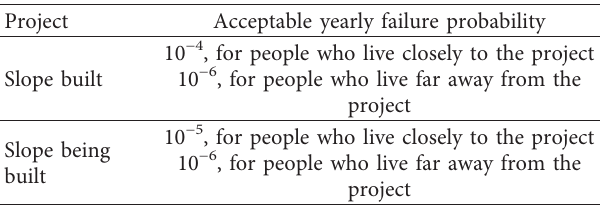
Table 2: The risk control standard of slope proposed by Fell [29].